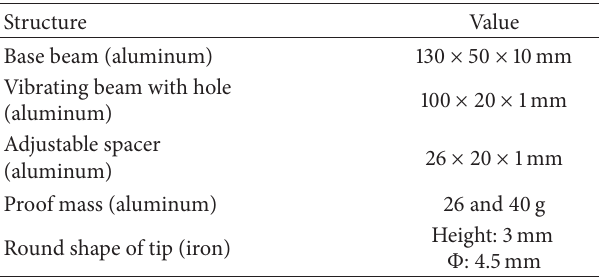
Table 2: Specifications of the structures of the power